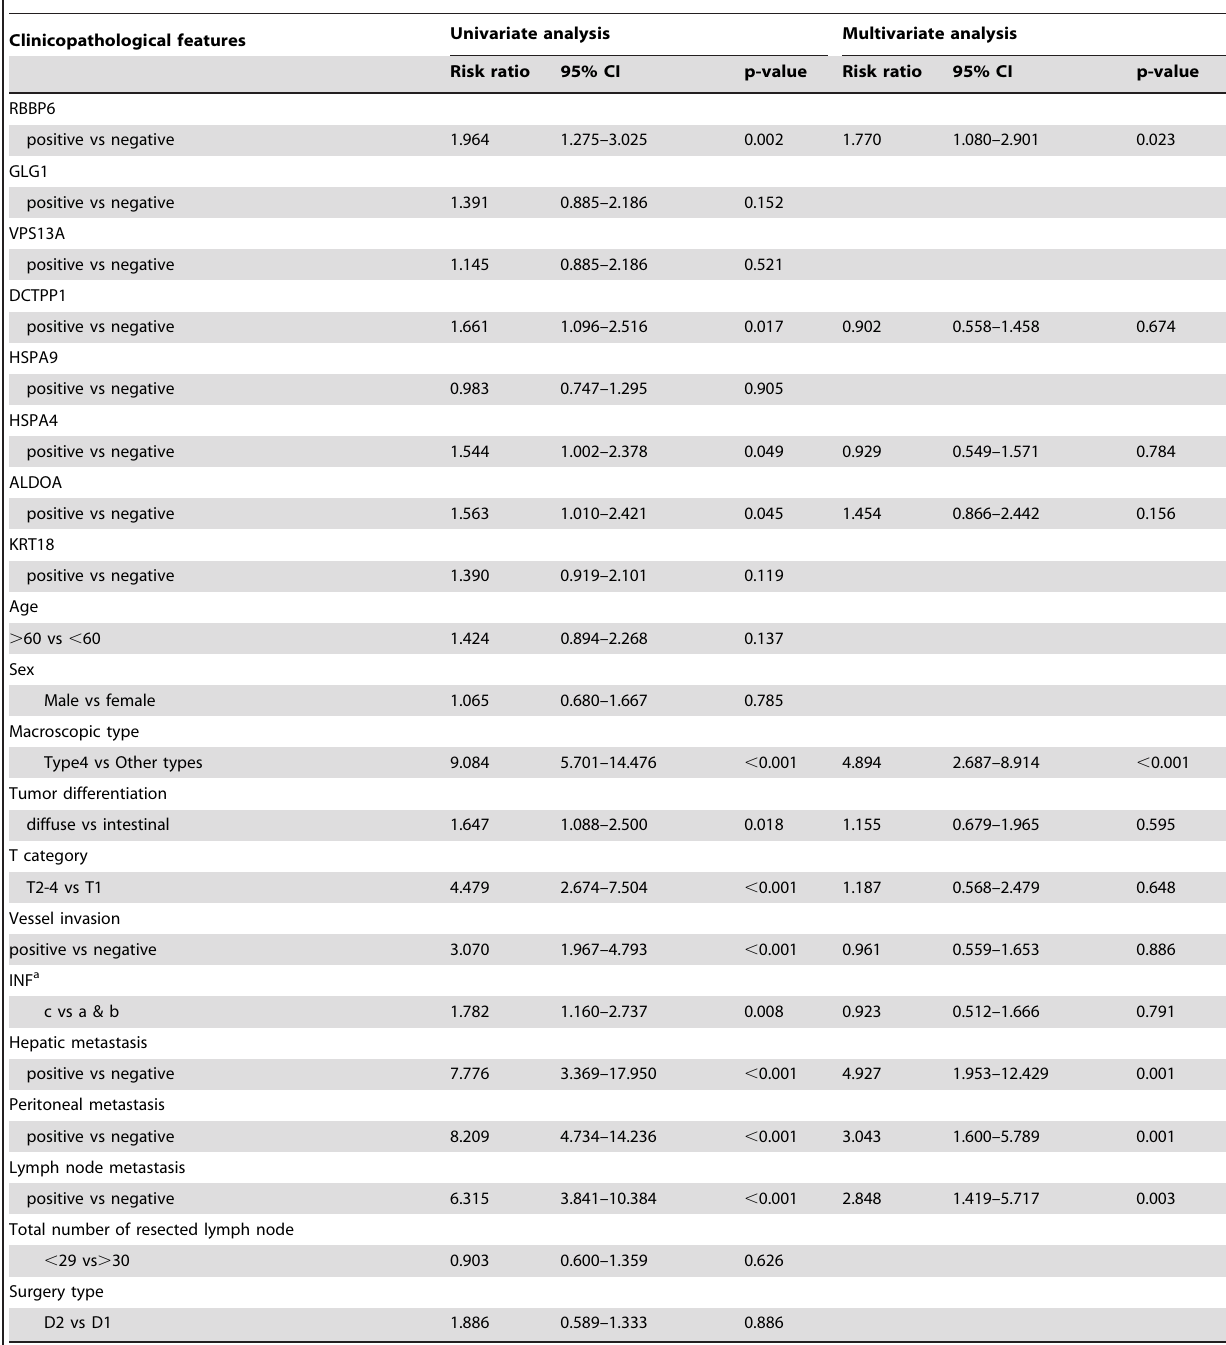
Table 4. Univariate and multivariate analyses with respect to